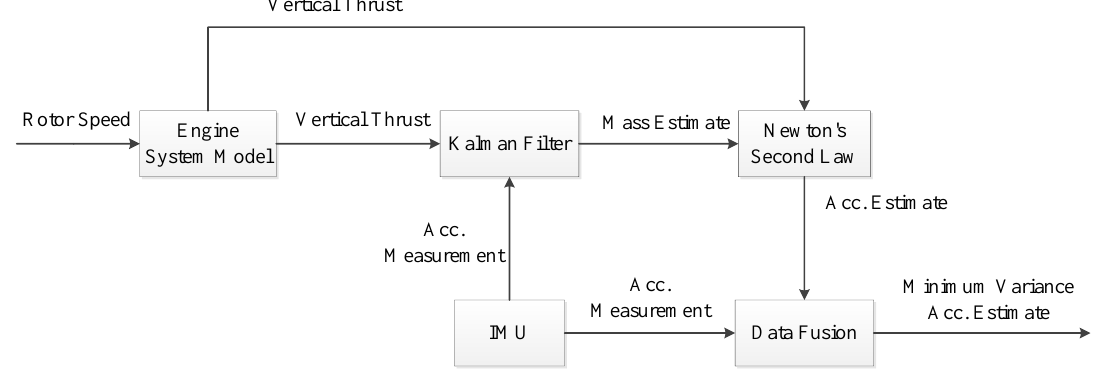
Figure 10. Flowchart of the noise reduction procedure developed in this